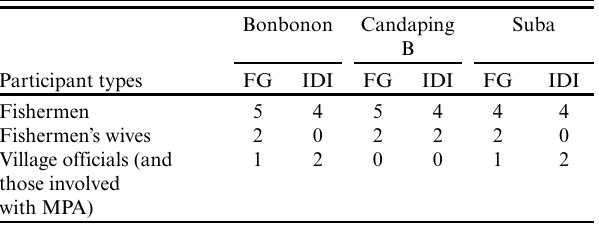
Table 2 . Study design highlighting the number and types of focus groups, in-depth interviews, and semistructured interviews carried out at each